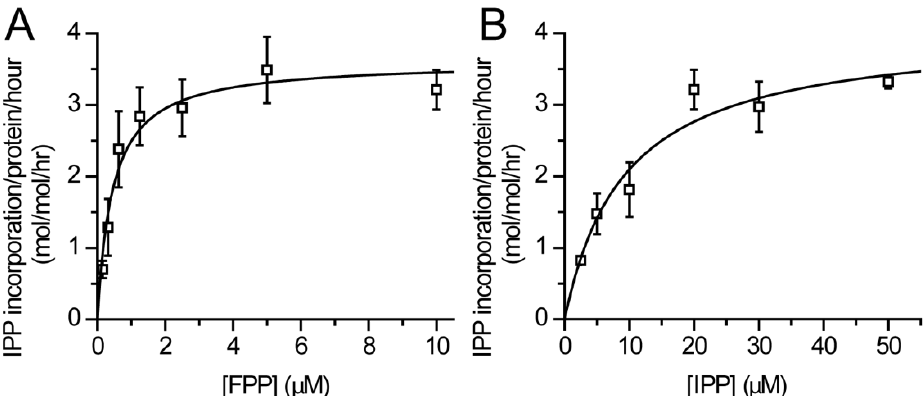
Figure 3. In vitro catalytic activity of purified DHDDS. ( A , B ) In vitro activity of purified human DHDDS with FPP and 14 C-IPP as substrates, assessed as IPP incorporation. ( A ) FPP-dependent activity in the presence of 20 µ M 14 C-IPP. ( B ) IPP-dependent activity in the presence of 10 µ M FPP. Initial rates were obtained by quenching the reaction at < 10% substrate consumption. Data are presented as mean ± SEM ( n = 3).